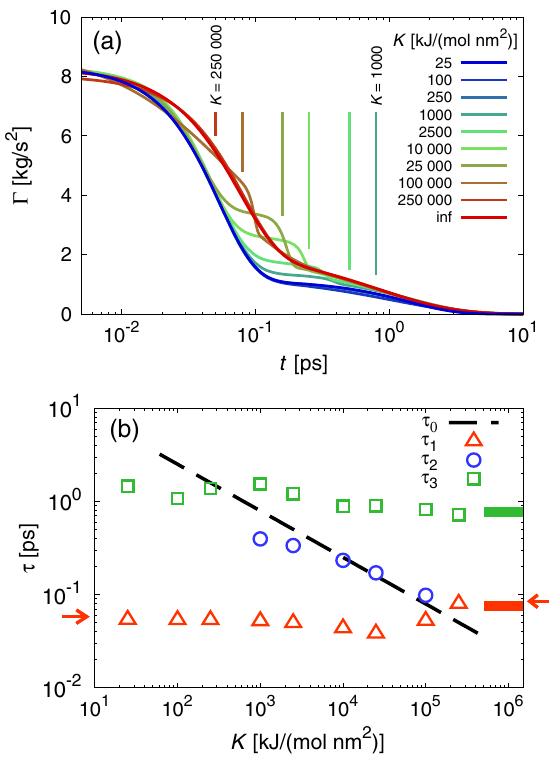
FIG. 3. Memory kernels. (a) Best-fit memory functions Γ ð t Þ according to the parametrization Eq. (7) for box size L ¼ 4 . 5 nm and different K . The result for the frozen case K ¼ ∞ is shown as a ffiffiffiffiffiffiffiffiffiffi p m=K red line. The harmonic oscillation periods τ 0 ¼ 2 π are indicated by vertical lines. (b) Fitted decay times τ (data points) i from Eq. (7) as a function of K . Statistical errors are smaller than the symbol size. The two time scales for the frozen limit K ¼ ∞ are denoted by horizontal colored lines on the right. The harmonic ffiffiffiffiffiffiffiffiffiffi p m=K oscillation period τ 0 ¼ 2 π is shown as a dashed line, the relaxation times in the K ¼ 0 and K ¼ ∞ limits estimated from methane-water repulsive interactions are denoted by red